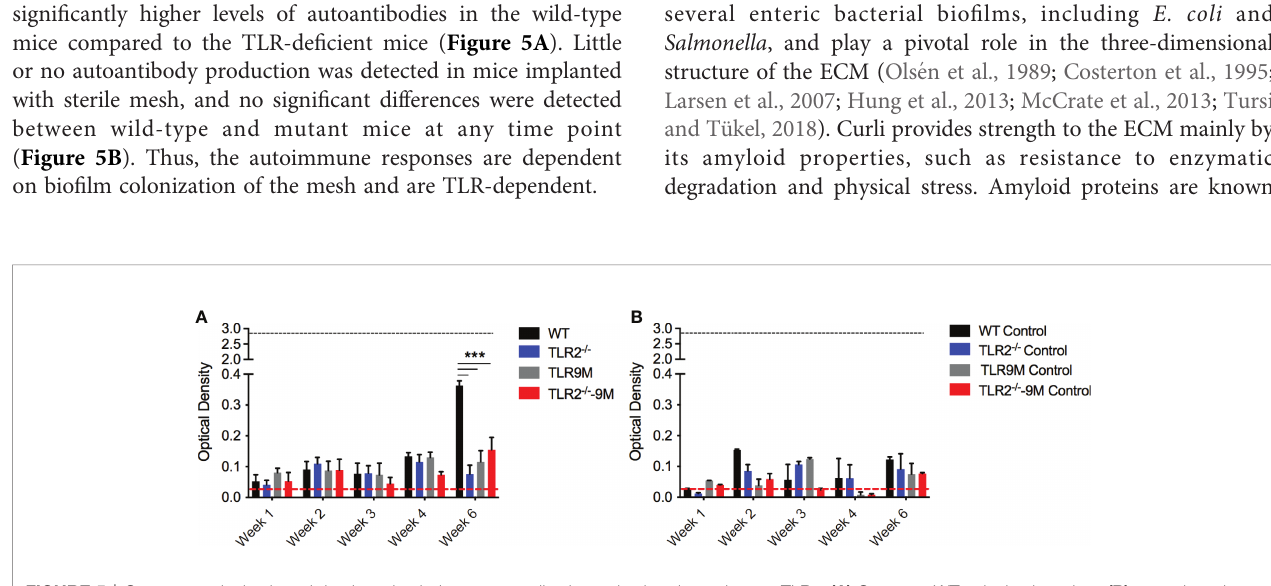
FIGURE 5 | S. aureus- colonized mesh implantation induces autoantibody production dependent on TLRs. (A) S. aureus WT colonized mesh or (B) control mesh was implanted subcutaneously into the back fl anks of C57BL/6 wildtype (WT) (black bars), TLR2 -/- (blue bars), TLR9 mutant (TLR9M) (gray bars), and TLR2 -/- - TLR9M (TLR2 -/ – 9M) (red bars) mice. Blood was collected via tail bleeding every week and sampled for production of anti-dsDNA autoantibodies (optical density 650- 405nm). Black dotted line represents the maximum autoantibody production of positive control sera and the red dotted line represent autoantibody detection in naïve serum. Mean and SEM graphed; signi fi cance was calculated using a 2-way ANOVA and Tukey ’ s multiple comparisons tests (***, P <